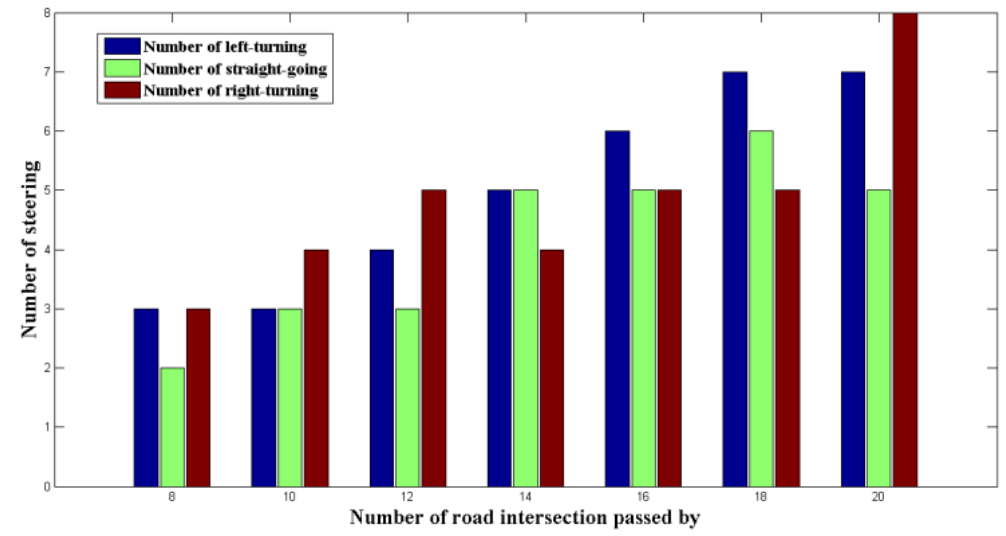
Figure 11. Statistics of the number of turns made at road intersections based on the traditional shortest path